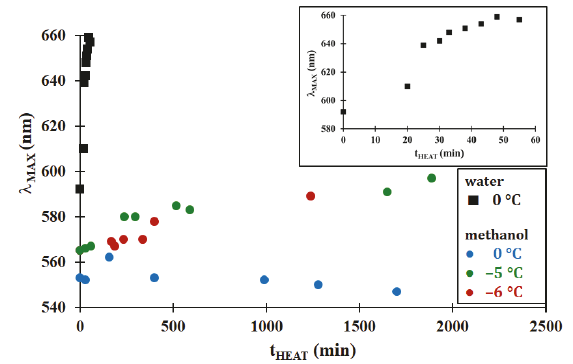
Figure 4: Effect of multiple drying-redissolving cycles on the fluorescenceemissionpropertiesofmercaptosuccinicacid-modified CdSe